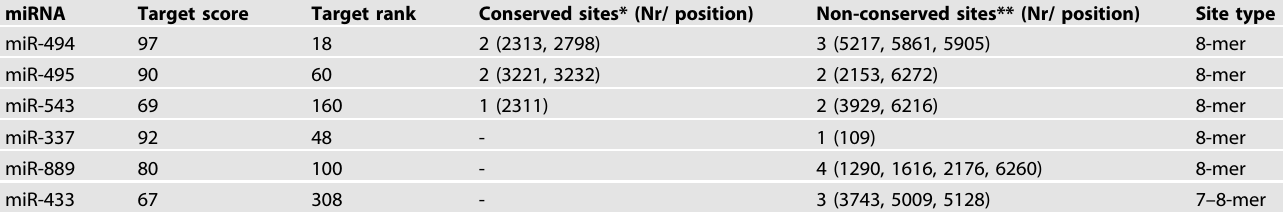
Table 1. Putative binding sites of 14q32 cluster miRNAs to PTEN 3 ′ UTR.